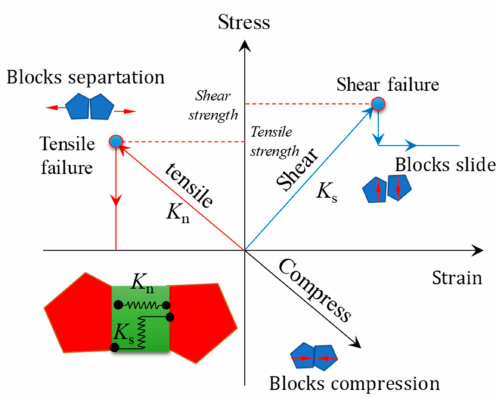
Figure 9. Vorinoi element constitutive model and parameter